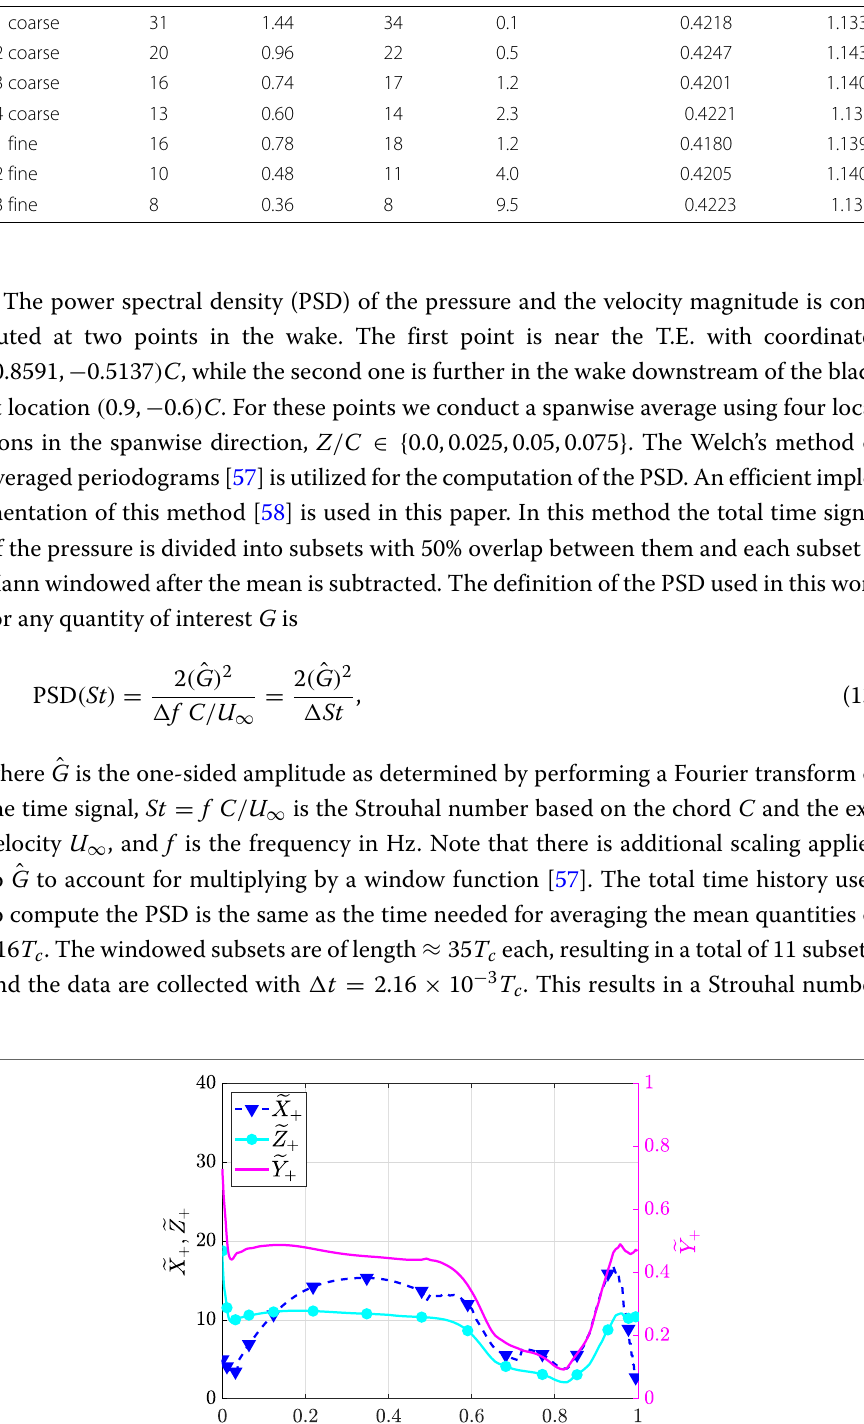
(cid:16) (cid:15) (cid:14) (cid:14) (cid:14) over the blade surface, nDOF, and the X + , Y + , Z +